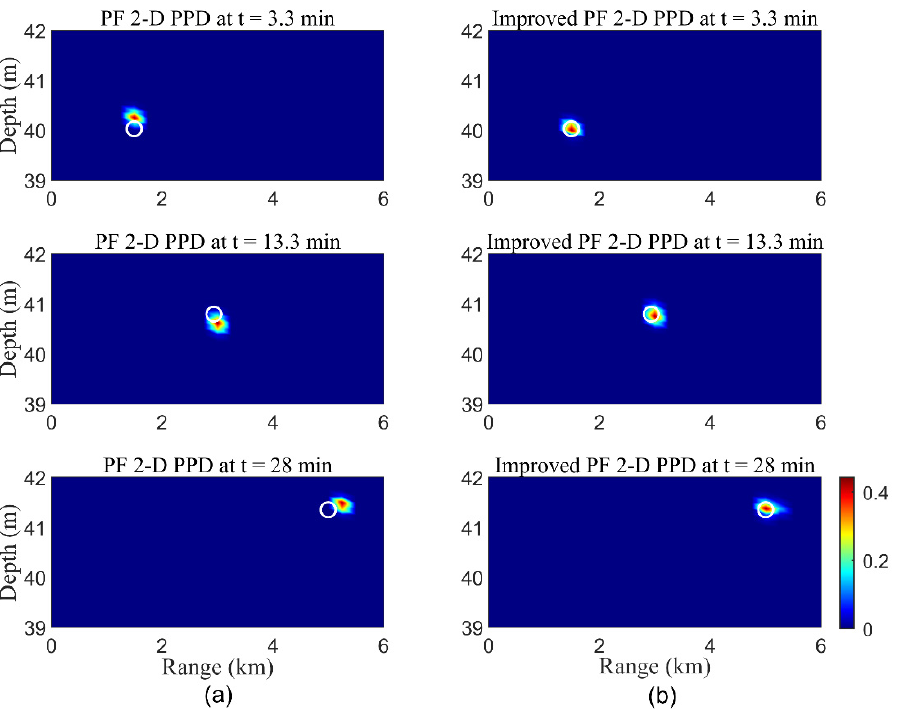
Figure 4. Two-dimensional depth-range marginal PPDs of ( a ) PF and ( b ) improved PF for the moving